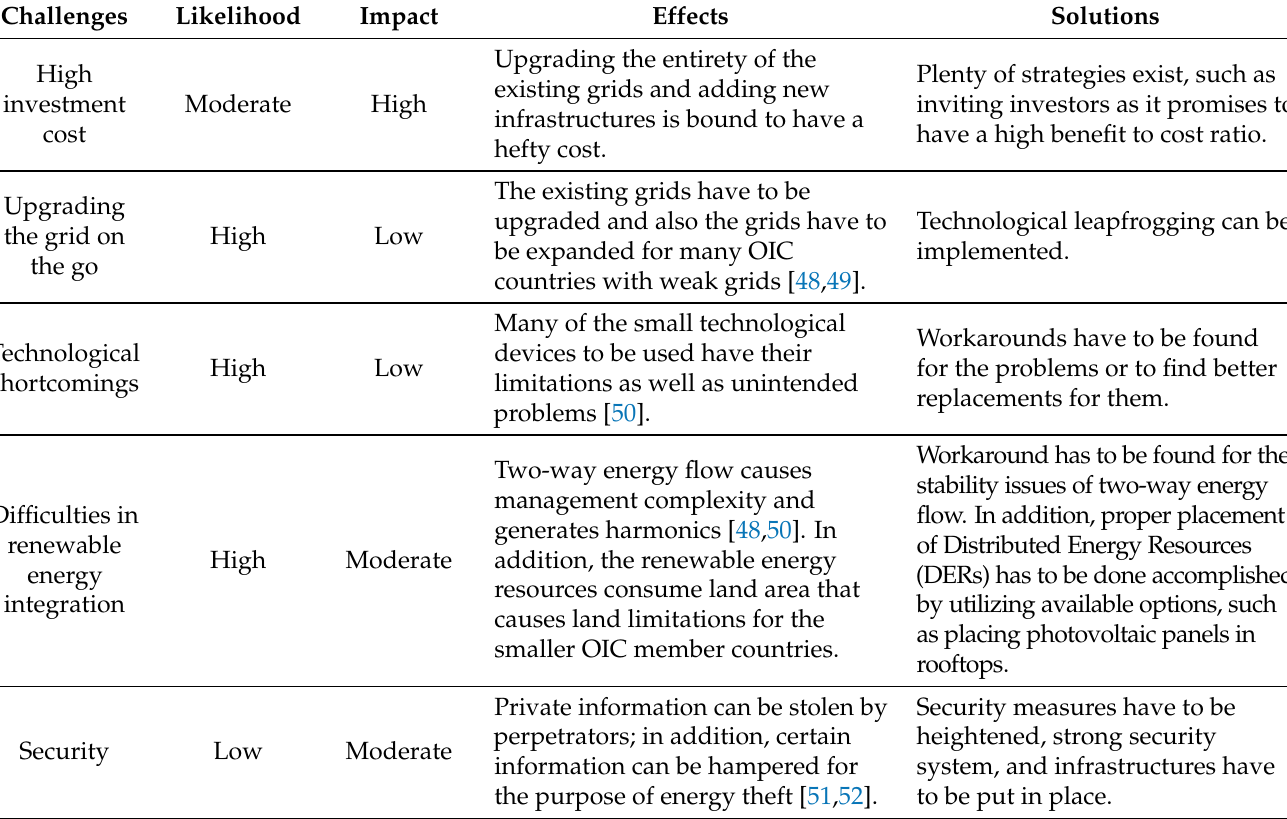
Table 4. General challenges of adopting the smart power management initiative for the OIC